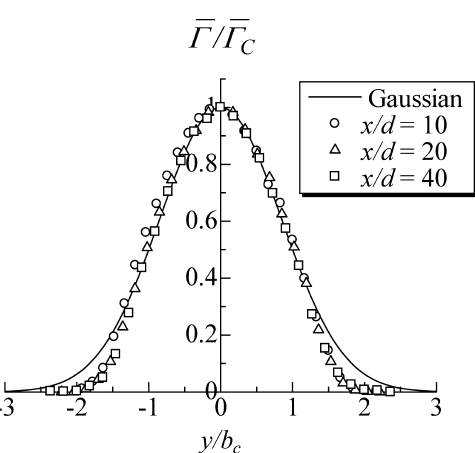
Fig. 4 Cross-streamwise profiles of mean concentration of nonreactive scalar.